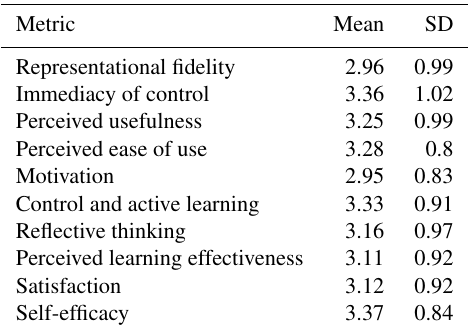
Table 2. Five-point scale survey